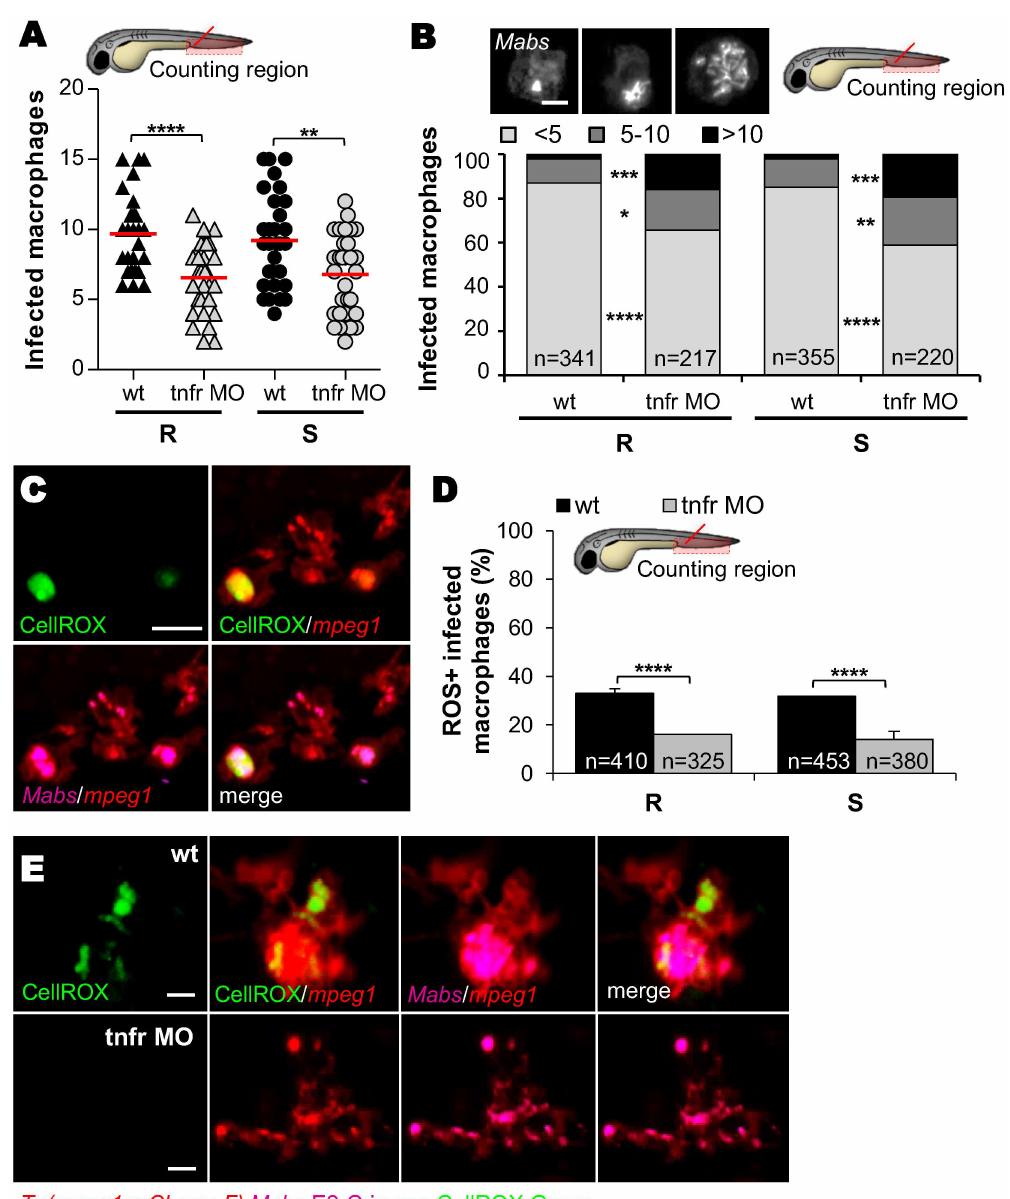
Fig 3. Inhibition of intramacrophage Mabs growth correlates with TNF-mediated ROS production. (A-E) WT or tnfr morphant Tg(mpeg1 : mCherry-F) embryos were iv infected with (cid:25) 150 R or S Mabs expressingtdTomato (A and B) or E2 crimson (C-E). (A) Number of infected macrophages in the caudal hematopoietic tissue (CHT) at 4 hpi. Horizontallines indicate the mean values. (B) Average proportions of macrophages containing < 5, 5 to 10, or > 10 bacteria in the CHT at 1 dpi (n = 20 embryos for each group). Top panel shows confocal images of each representative class of infected macrophages. Scale bar, 5 μ m. (C-E) CellRoxgreen (green) staining of ROS productionin infected embryos. (C) Confocal microscopy of ROS-positive infected macrophages. Scale bars, 10 μ m. (D) Average proportions ROS-producing macrophages within the CHT in 1 dpi embryos (n = 30 embryos for each group). Error bars represent the SEM. (E) Representative fluorescence microscopy of 3 dpi-granuloma. Scale bars, 10 μ m. Statistical significance was determinedby one-tailed unpairedStudent’s t test (A) or Fisher’s exact test of a contingency table (B and D). Data are representative of two independent